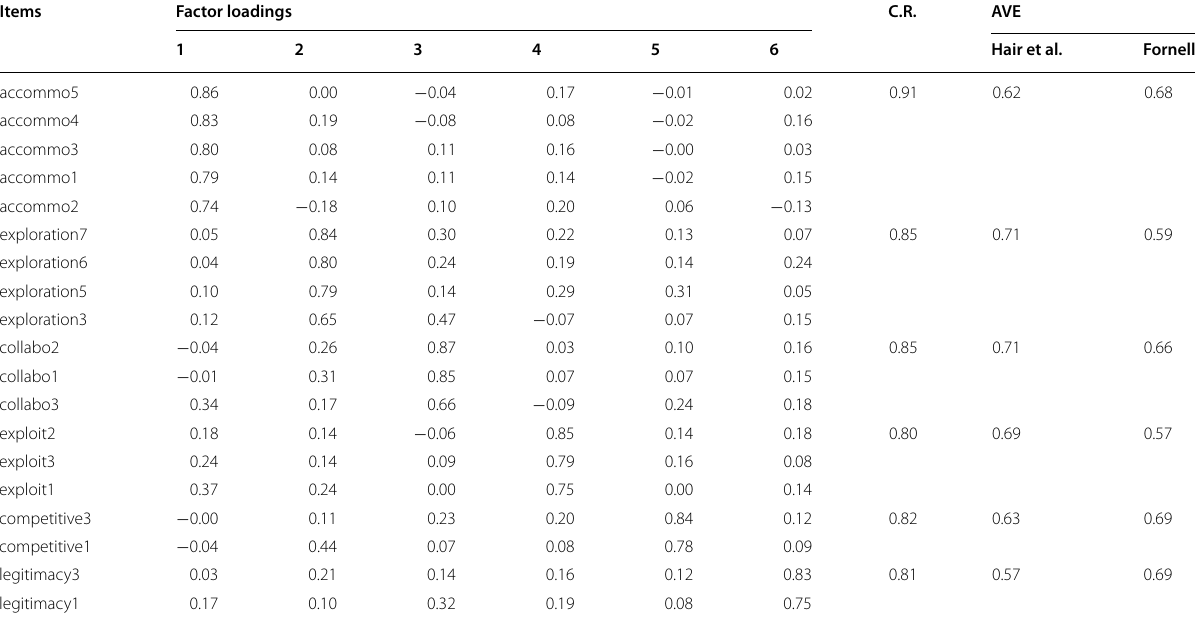
Table 4 Factor Loadings, Composite Reliability, and Average Variance Extracted